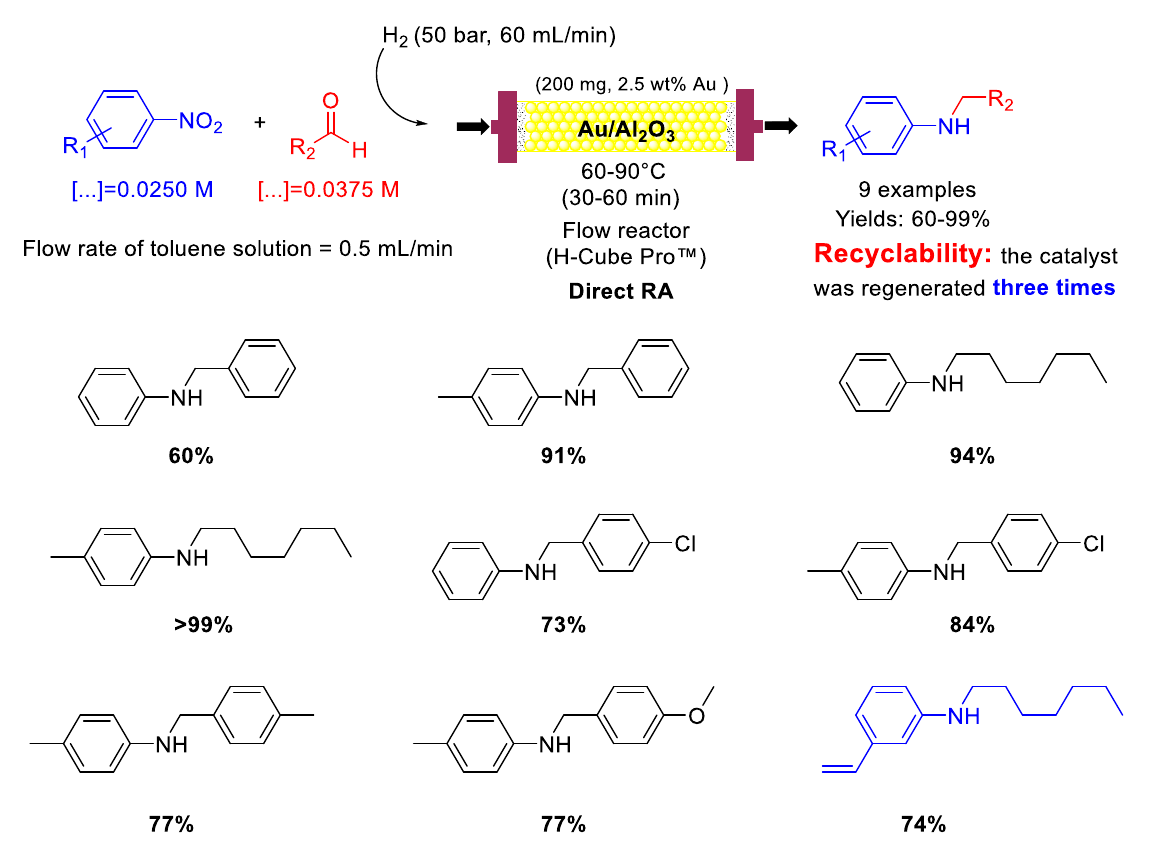
Scheme 30. DRA catalysed by Au/Al 2 O 3 in flow